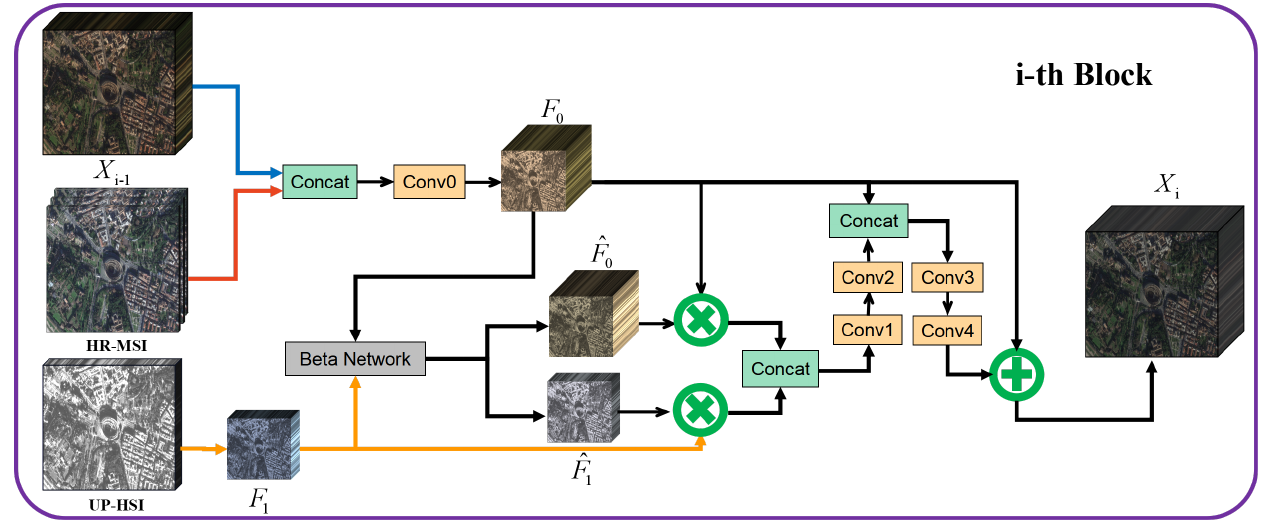
Figure 4. The architecture of the lightweight residual constraint block based on global variance fine-tuning